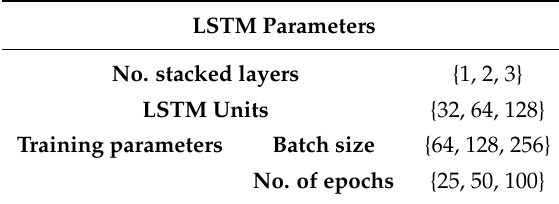
Table 2. Parameter search for LSTM models for both